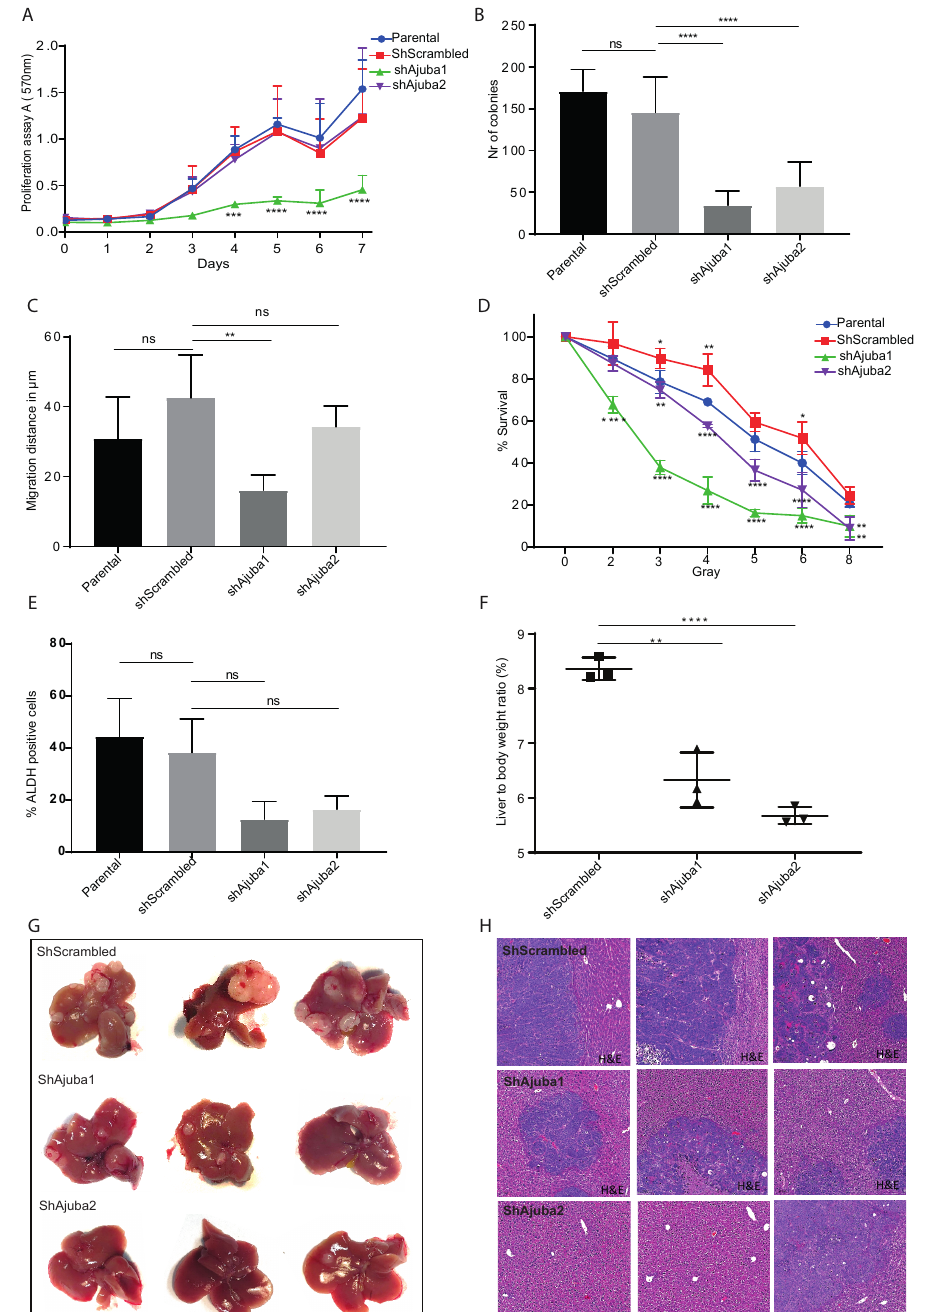
Figure 6. Ajuba KD reduces cell migration, colony formation and metastatic tumor burden in Rag2 − / − gamma(c) mice. ( A ) Proliferation assay measuring the absorbance at 570 nm after addition of MTT over the span of one week. Statistics were computed with Graphpad performing a two-way Anova with Tukey corrections for multiple comparisons ( n = 3 a combination of all 3 independent experiments are displayed here). Day 4: Shscrambled vs. shAjuba1 = 0.0008, Day 5: Shscrambled vs. shAjuba1 ≤ 0.0001, Day 6: Shscrambled vs. shAjuba1 ≤ 0.0001, Day 7: Shscrambled vs. shAjuba1 ≤ 0.0001. ( B ) Graph displaying number of colonies for each condition. The colonies are stained with crystal violet and counted with ColCounter. Parental vs. shScrambled = 0.1410, Shscrambled vs. ShAjuba1 ≤ 0.0001, shScrambled vs. shAjuba2 ≤ 0.0001. ( C ) Migration assay showing difference of the radius in µ m, calculated between day 0 and day 1 of the migration. Measurement of areas was done by ImageJ.